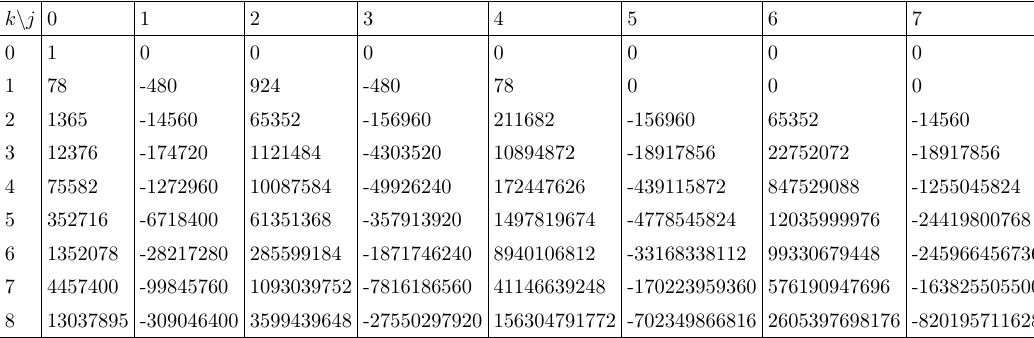
Table 38. Table of b jk coe(cid:14)cients for h Sp(6)